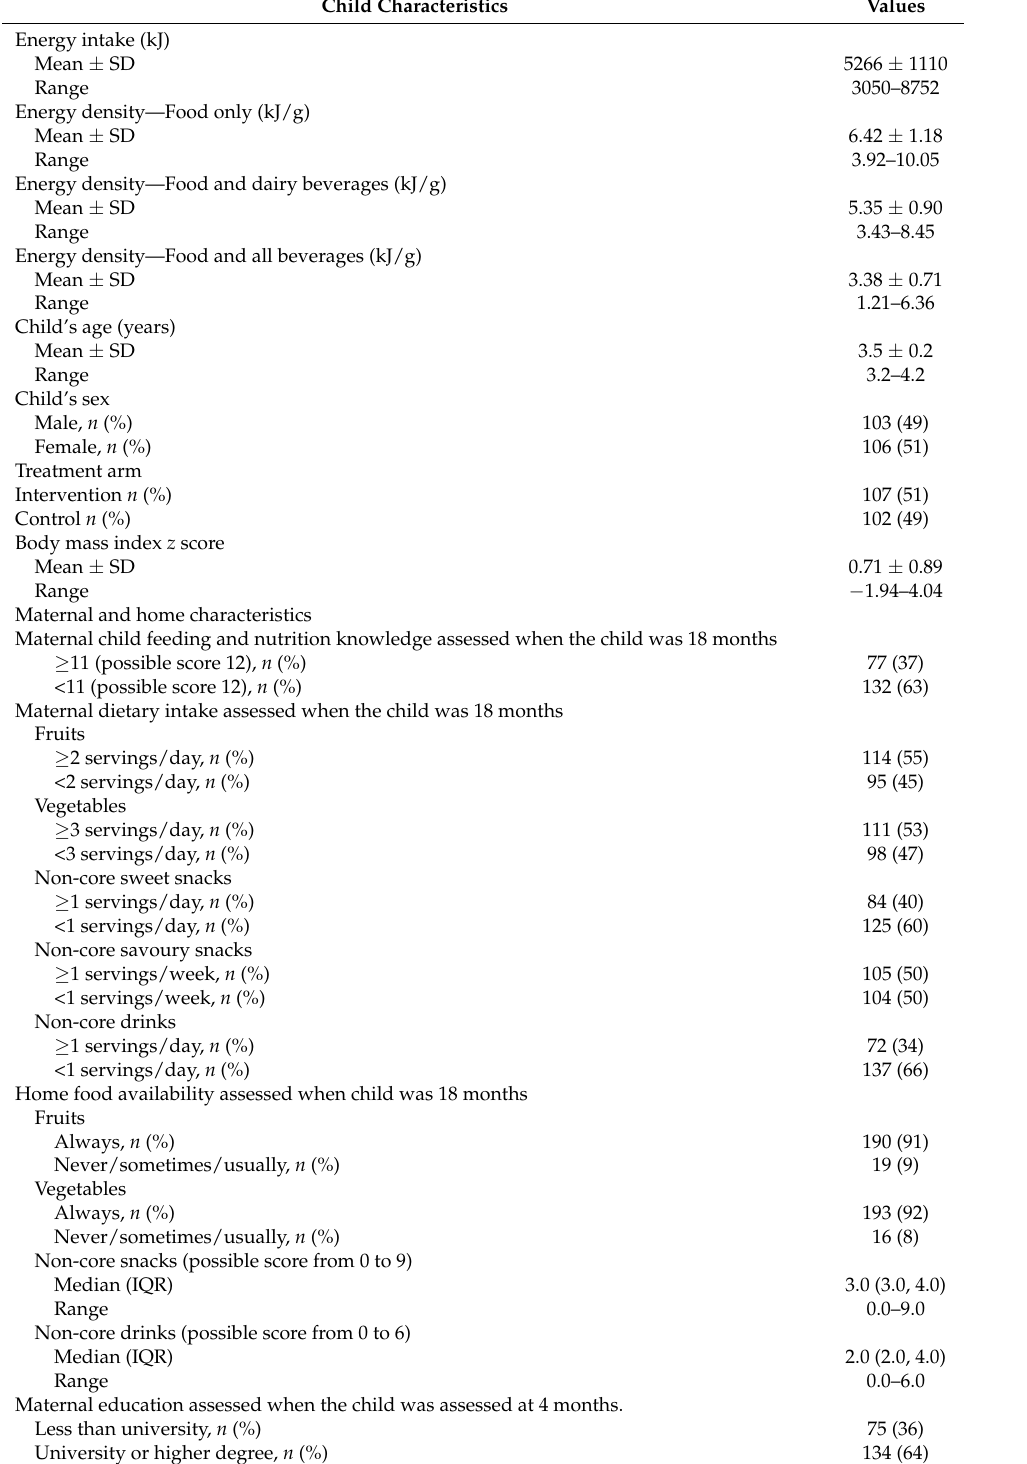
Table 2. Characteristics of children, mothers and homes in the Melbourne InFANT